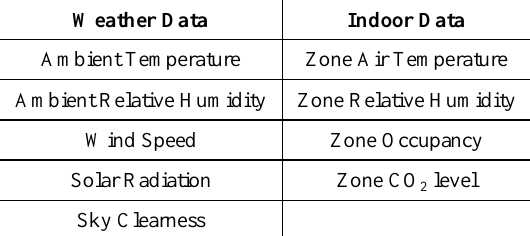
Table 3. Input variables under